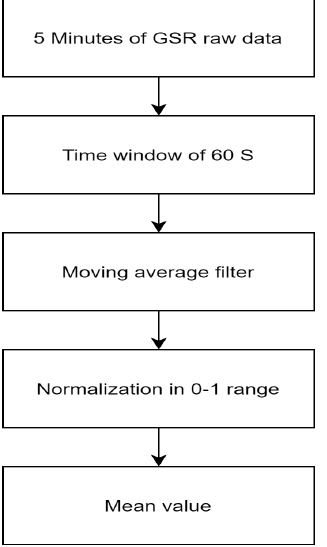
Figure 5. Algorithm used for GSR